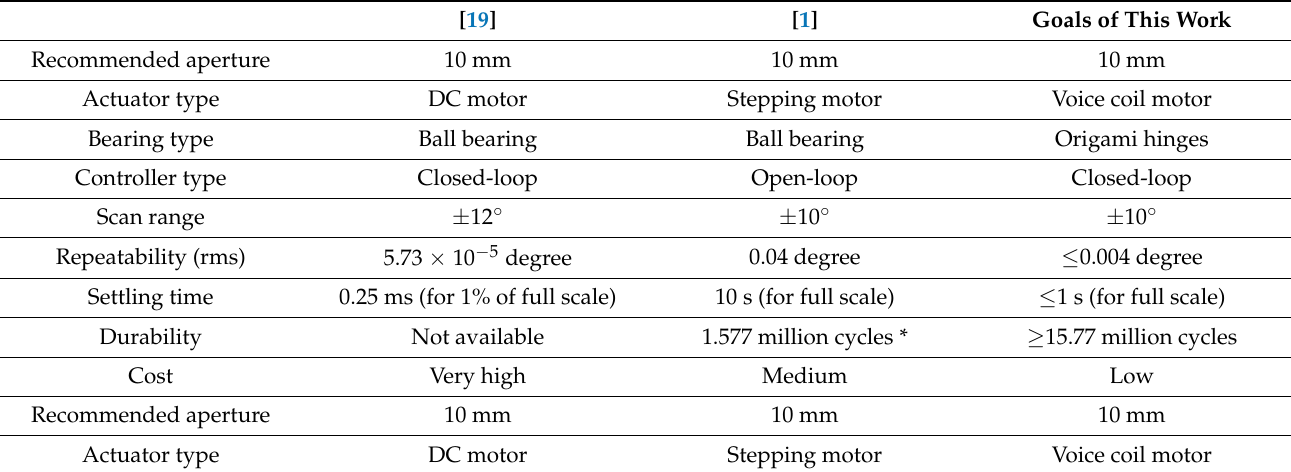
Table 1. Main specifications of typical 10 mm aperture laser